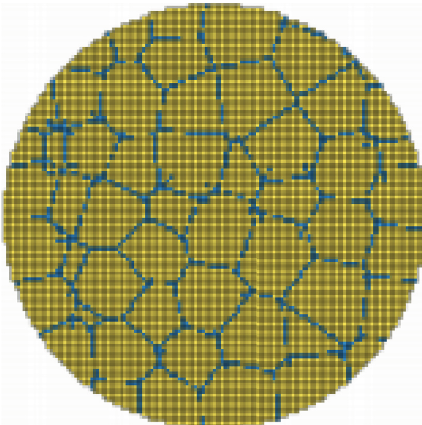
Figure 1: The real structure and numerical simulation structure of aluminum